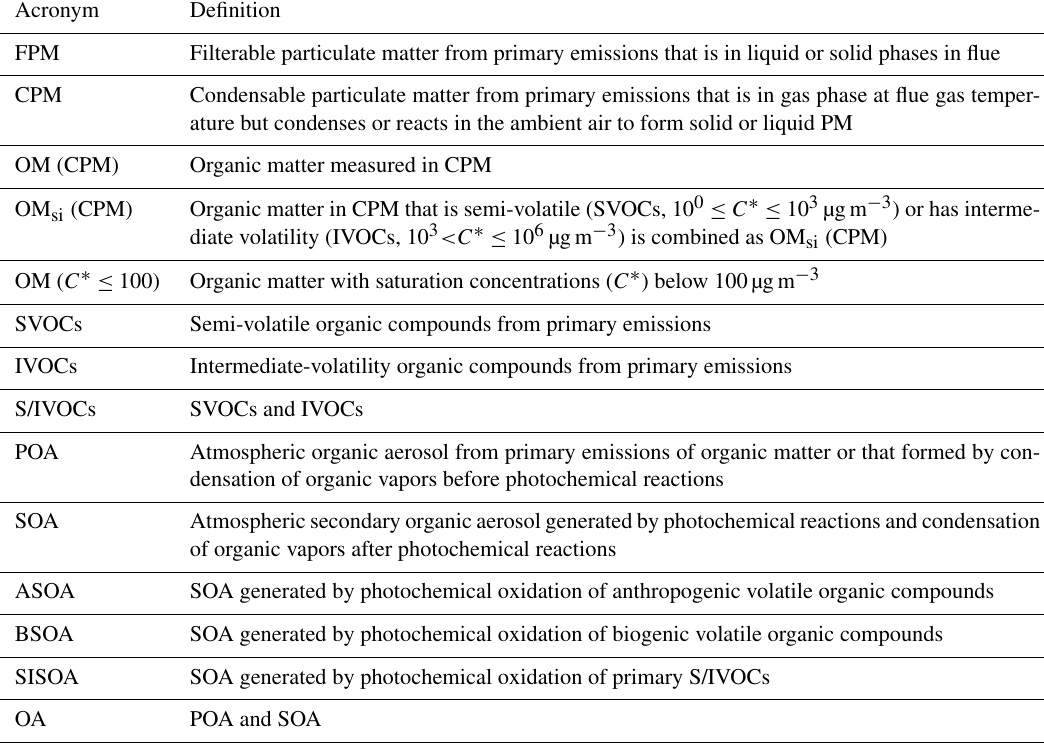
Table 1. Definitions of acronyms used in this study.